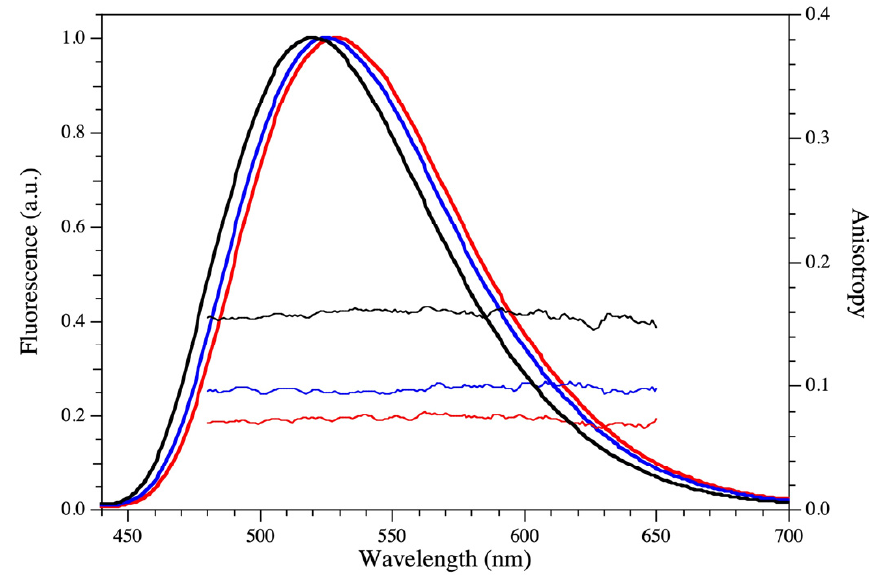
Figure 3. Fluorescence emission (left axis) and anisotropy (right axis) of Ge1 in the 440–700 interval upon 420 nm excitation. Red: II -L. Blue: sc- II immediately after mixing. Black: sc- II 72 h after mixing. Experiments were carried out in PBS at 25 °C using 0.3 wt.% of L and D copolymers. The emission spectrum of Ge1 was blue-shifted by about 5 nm upon polymer mixing.